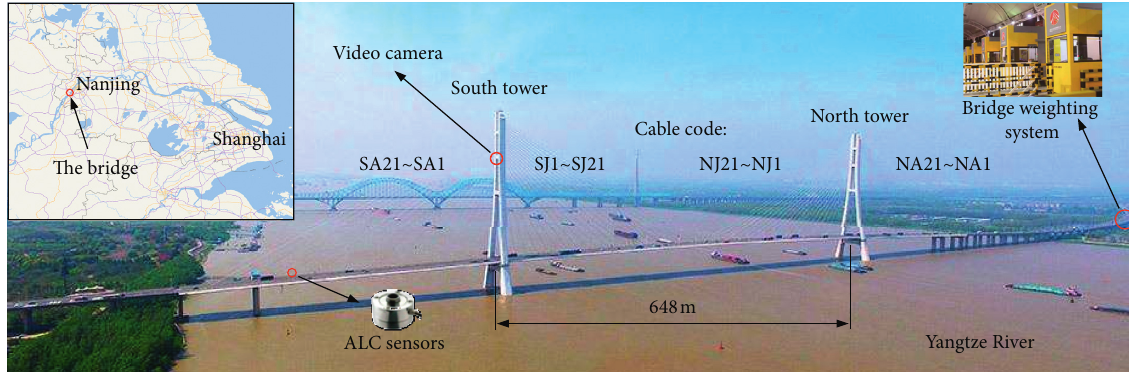
Figure 6: The third Nanjing Yangtze River Bridge.